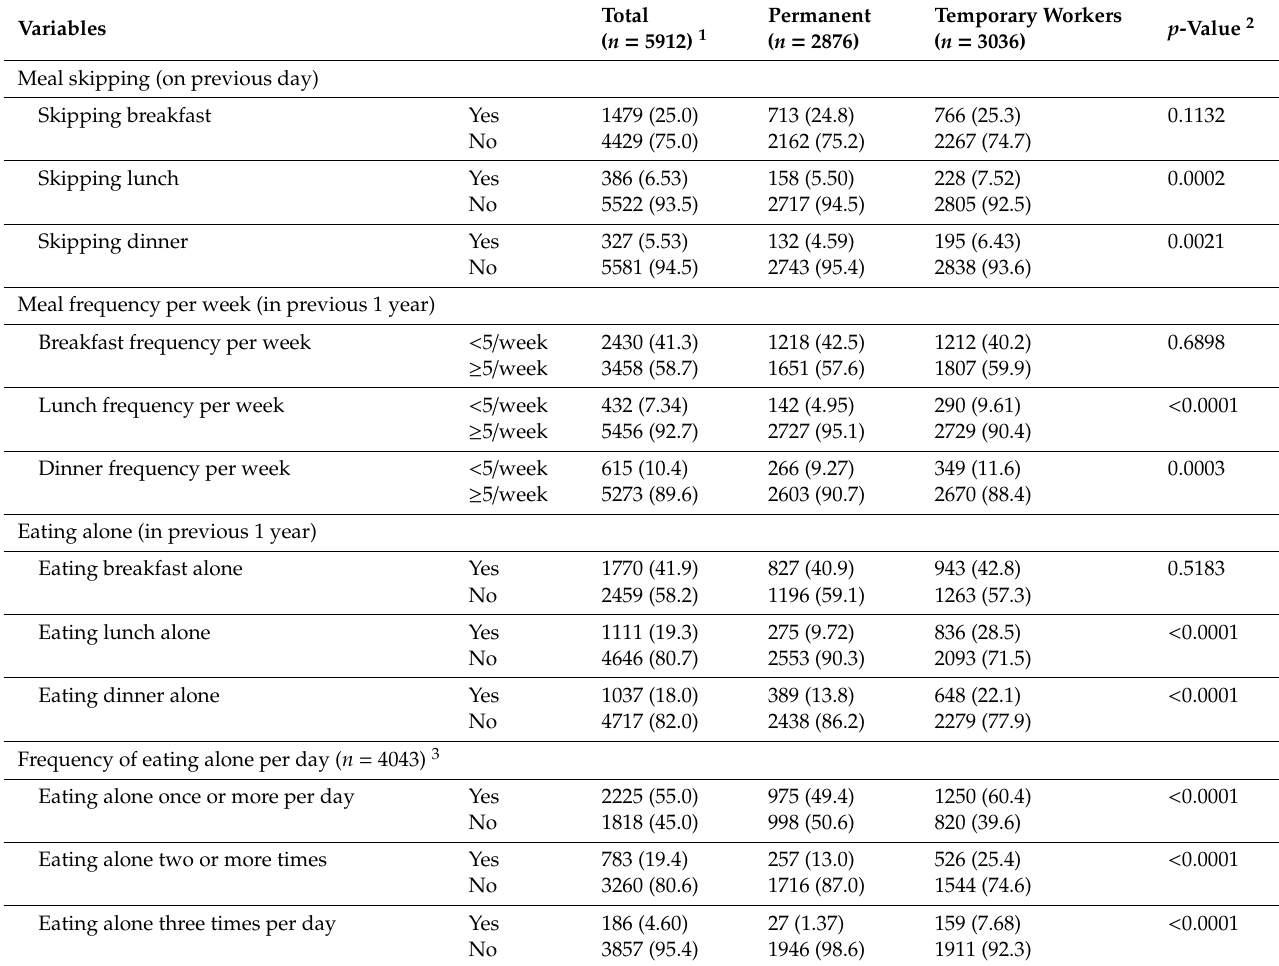
Table 2. Eating behaviors of participants by permanent and temporary worker status ( n =